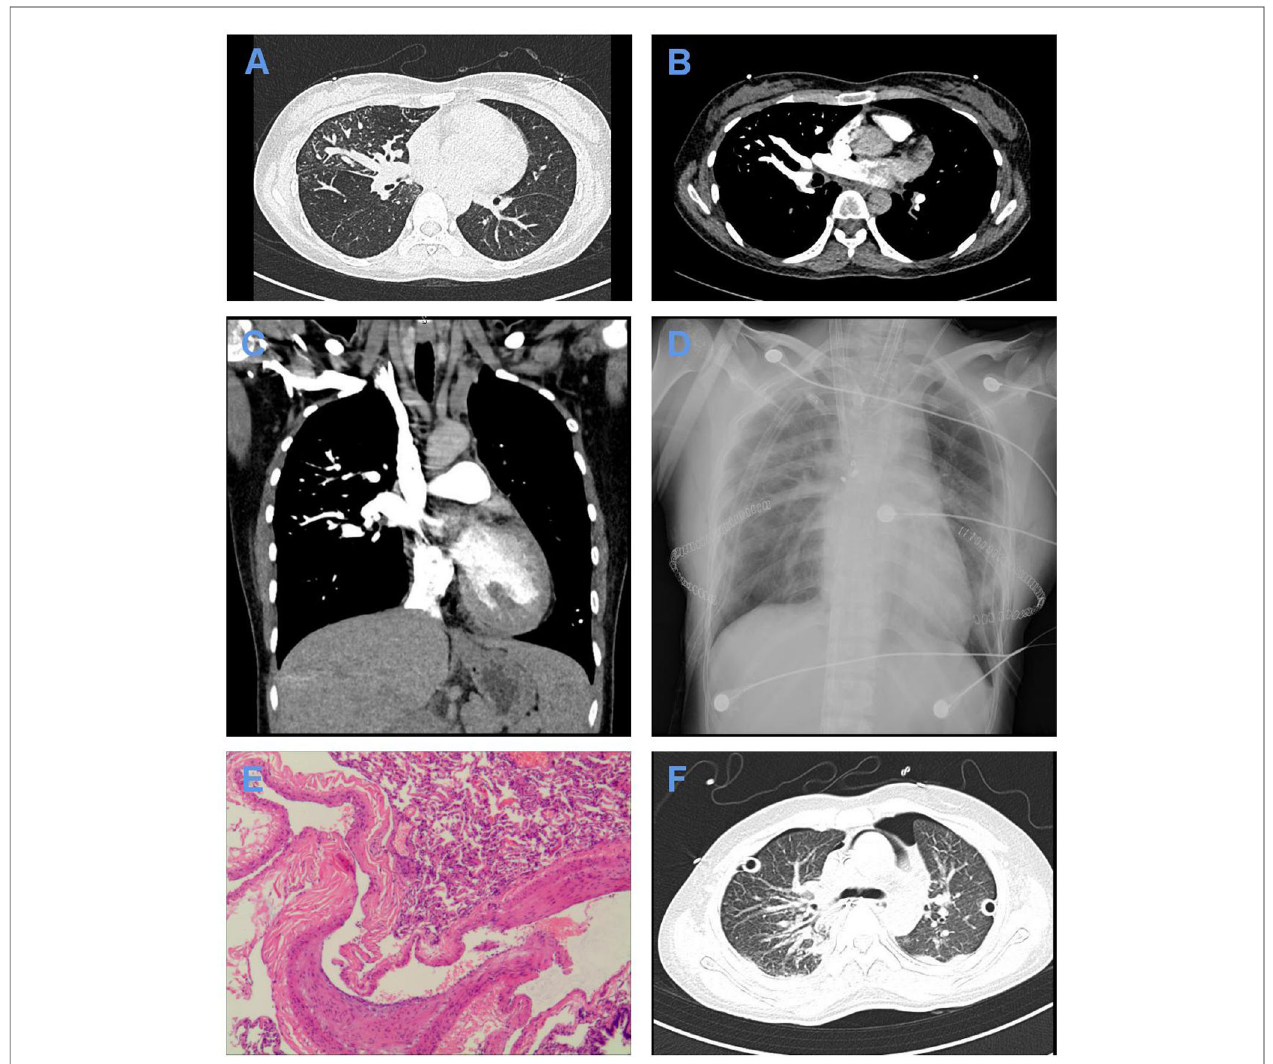
FIGURE 1 | Imaging and pathological data of the patient. ( A – C ) Lung window ( A ), mediastinal window ( B ), and 3D window ( C ) of CTPA after admission showing simultaneous fi lling of the pulmonary artery and pulmonary vein in the right lung and the lower lobe of the left lung fi ll. ( D ) X-ray of the chest on the fi rst postoperative day showing exudative changes in both lungs. ( E ) Pathological examination showing dilated blood vessels, different thicknesses of the blood vessel wall, partial anastomosis of the dynamic venous blood vessel wall, thickening of the intima of some blood vessels, and congestion and bleeding in the lung, conforming to the standard of PAVF with hemorrhage and secondary pulmonary hypertension. Scale: ×40. ( F ) Chest CT showing a small amount of pleural effusion on both sides, slight enlargement of the hilum of both lungs after double-lung transplantation, interstitial changes in both lungs with exudation, local pericardium thickening, and locally thickened pleura on both